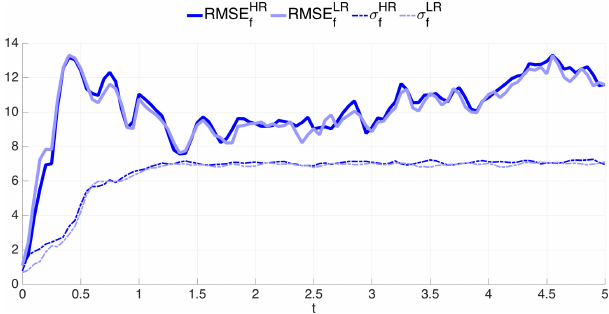
Figure 10. Same as Fig. 7, but using KSM.